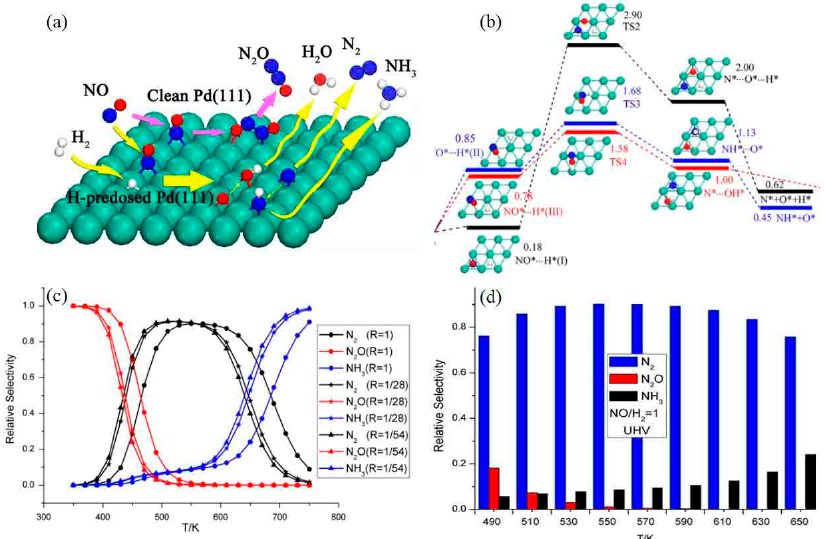
Figure 14. ( a ) Reaction pathways of NO + H 2 and products on Pd (111), ( b ) potential energy diagram and geometrical structure of H atom-assisted direct dissociation of NO on Pd (111), and ( c , d ) relative selectivity of N 2 , NH 3 , N 2 O, and H 2 O at different temperatures [212]. Reproduced from Ref. [212], Copyright 2015, Elsevier.